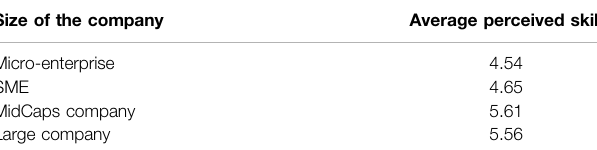
TABLE 4 | The average perceived skill for each size of company. Size of the company